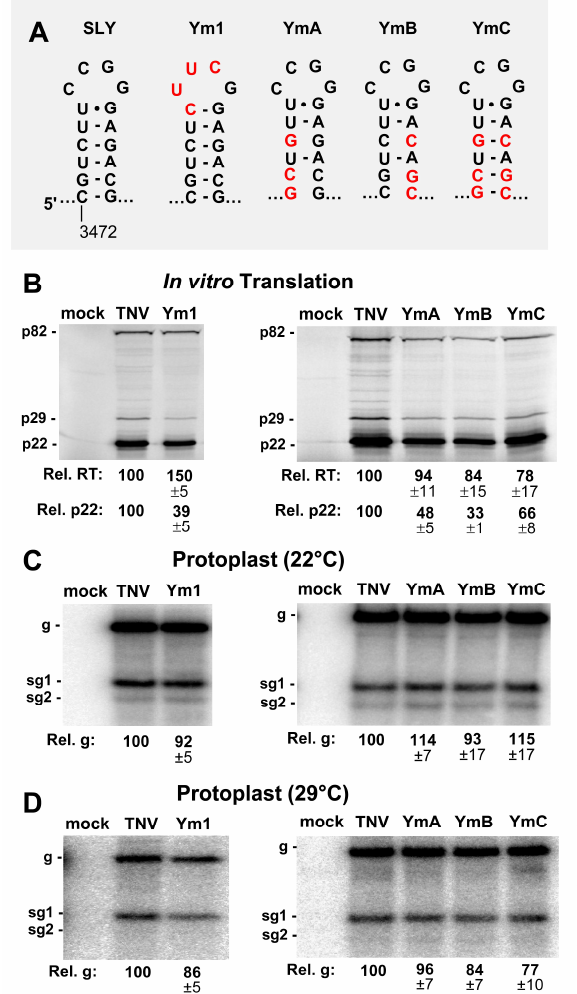
Figure 3. Mutational analysis of the SLY. ( A ) Wild-type and mutant SLYs, with substituted nucleotides in red. ( B ) In vitro translation analysis of the SLY mutants in panel A. ( C and D ) Northern blot analysis of the protoplast infections with SLY mutants at ( C ) 22 ◦ C and ( D ) 29 ◦ C.